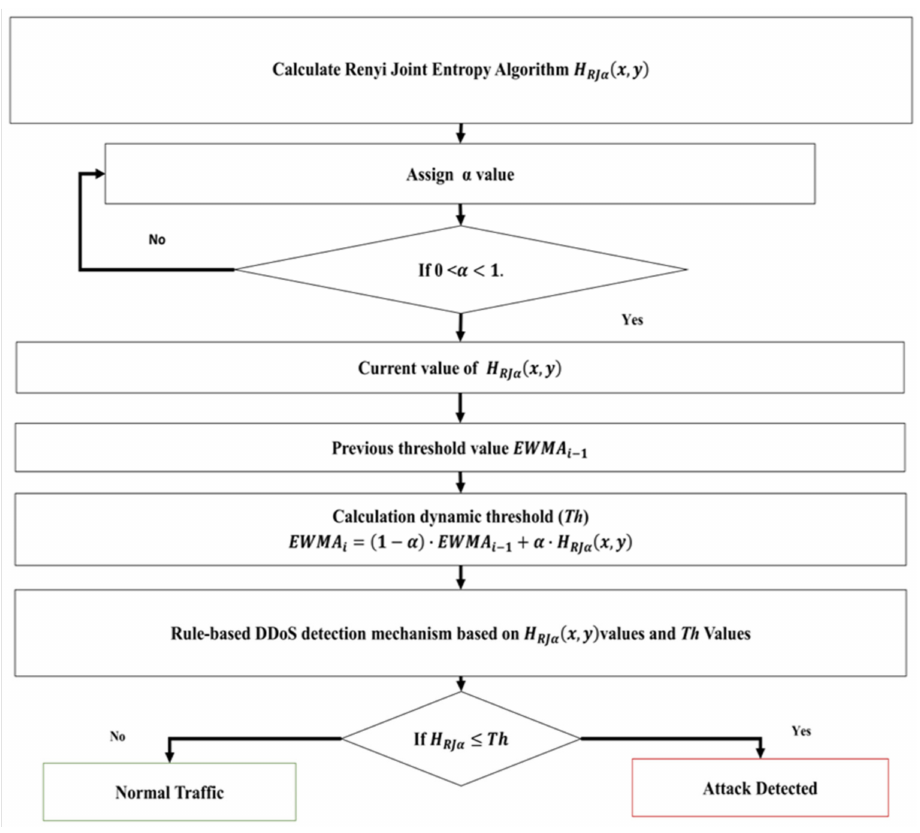
Figure 3. Proposed approach